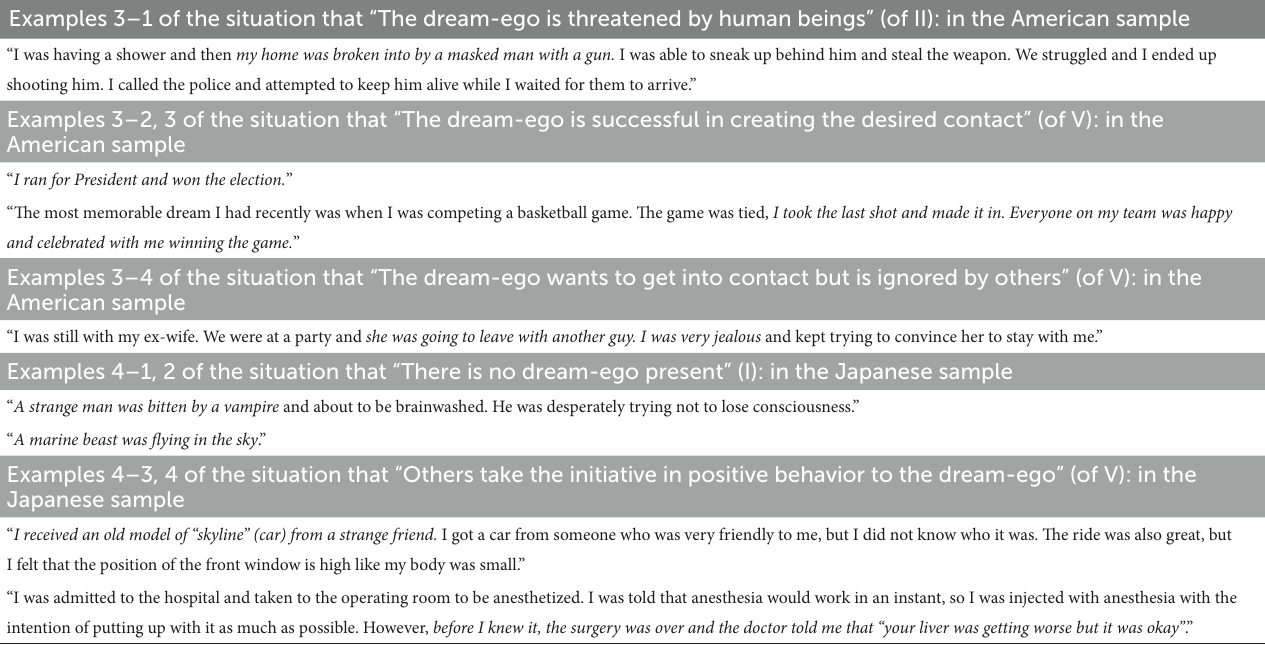
TABLE 7 Examples of the structural patterns identified in the American and the Japanese samples for “recent impressive dreams.” Examples 3–1 of the situation that “The dream-ego is threatened by human beings” (of II): in the American